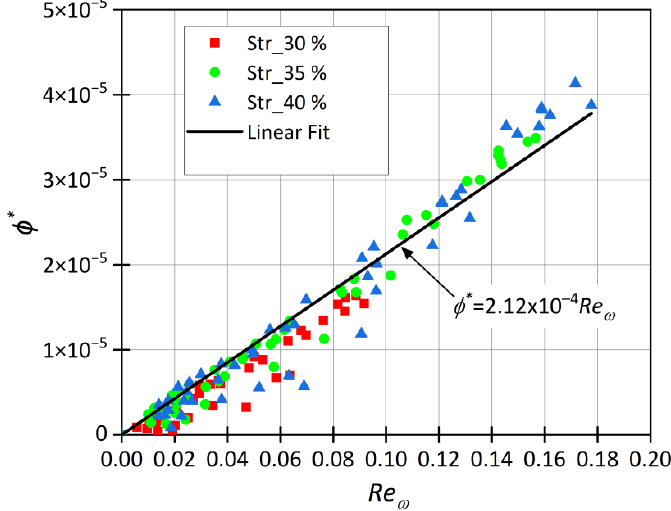
Figure 18. Modified phase shift correlations between pressure drop and velocity for different re-